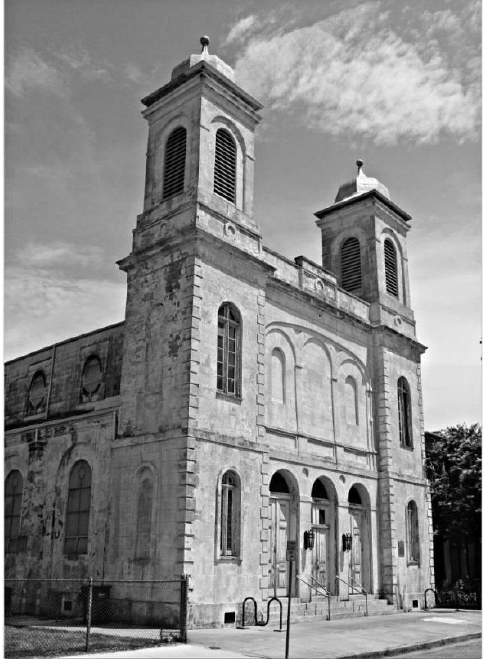
Figure 9. Holy Trinity Catholic Church, New Orleans, Louisiana; image from the website http://www.neworleanschurches.com/holytrinity/holytrin.htm (accessed on 28 June 2018); image credit John and Kathleen DeMajo. June 2017.